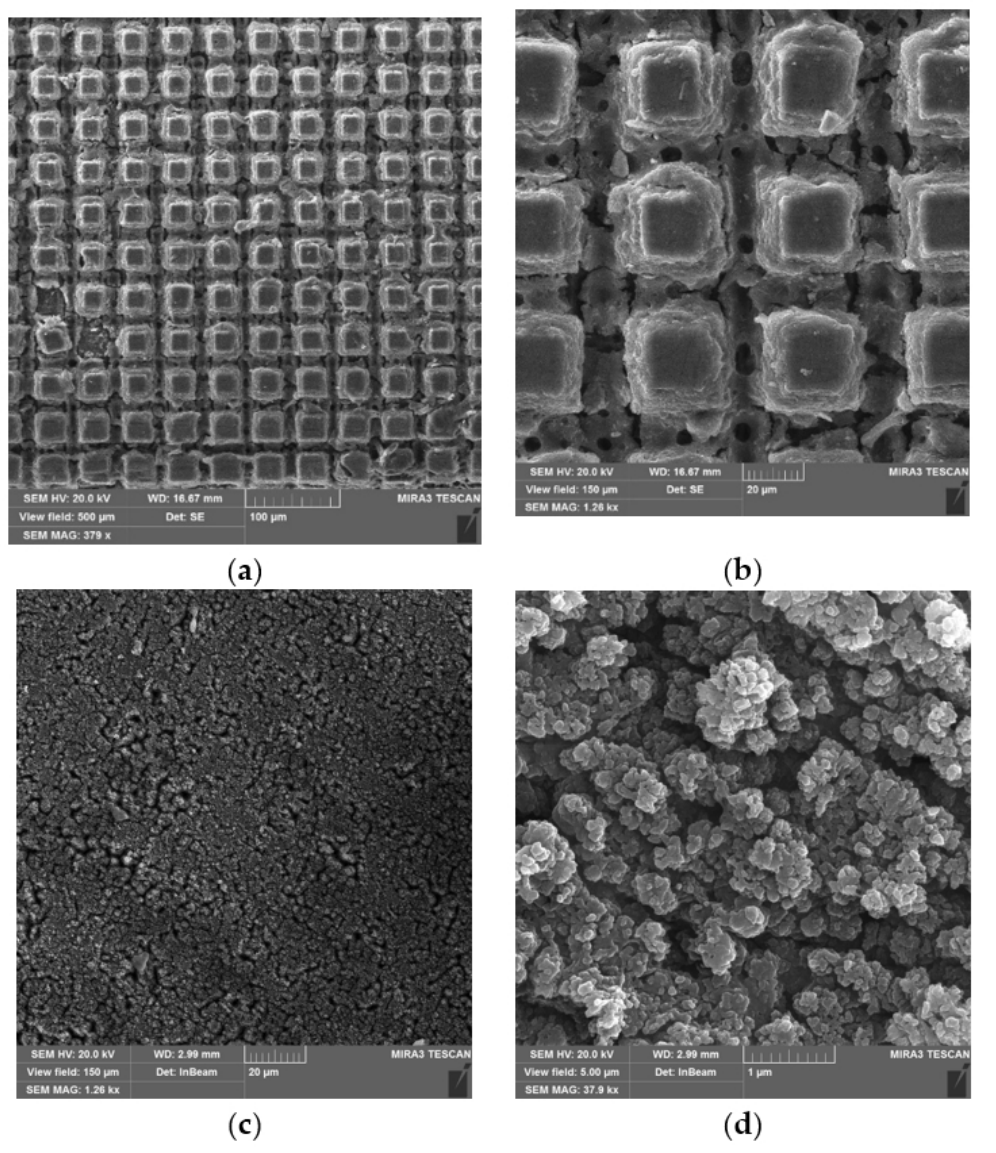
Figure 2. Laser-textured surface structures on 7500 series aluminum plates. ( a , b ) Rectangular micropattern (mAl);.( c , d ) Nanotexture